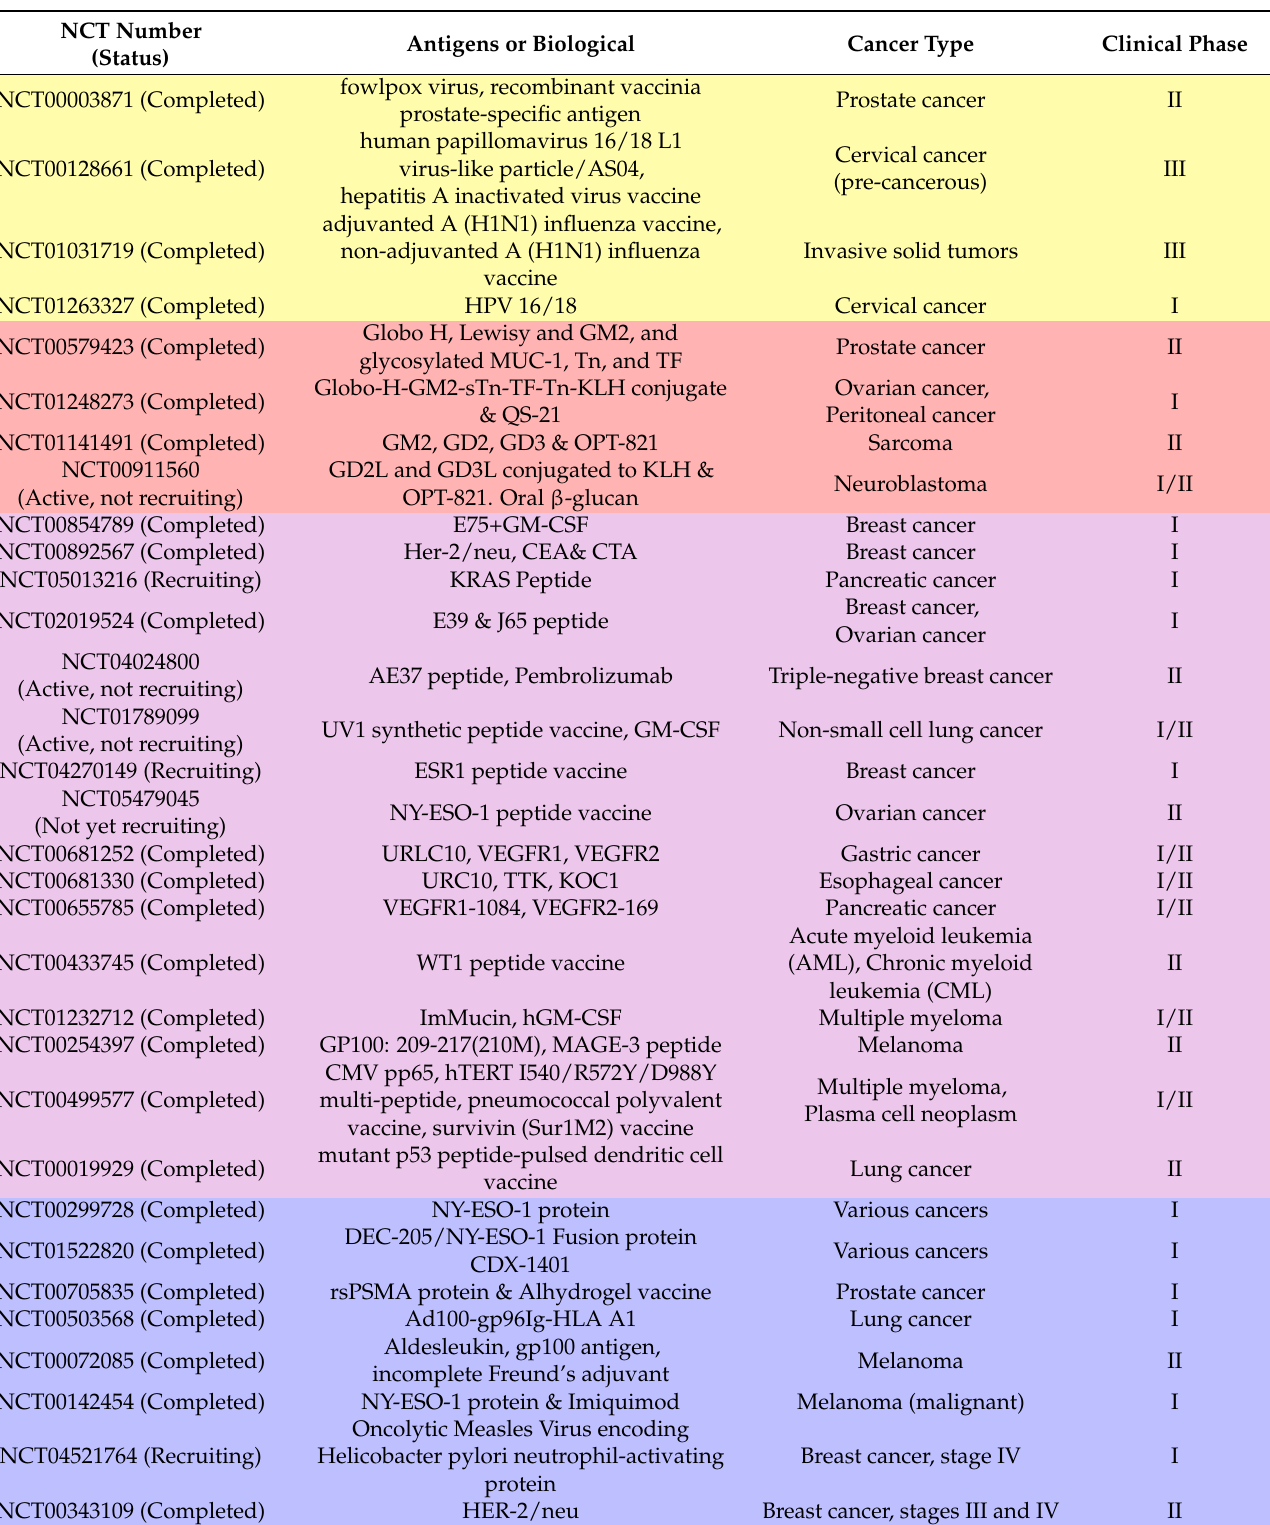
Table 1. Representative clinical trials utilizing antigens or biological materials in cancer